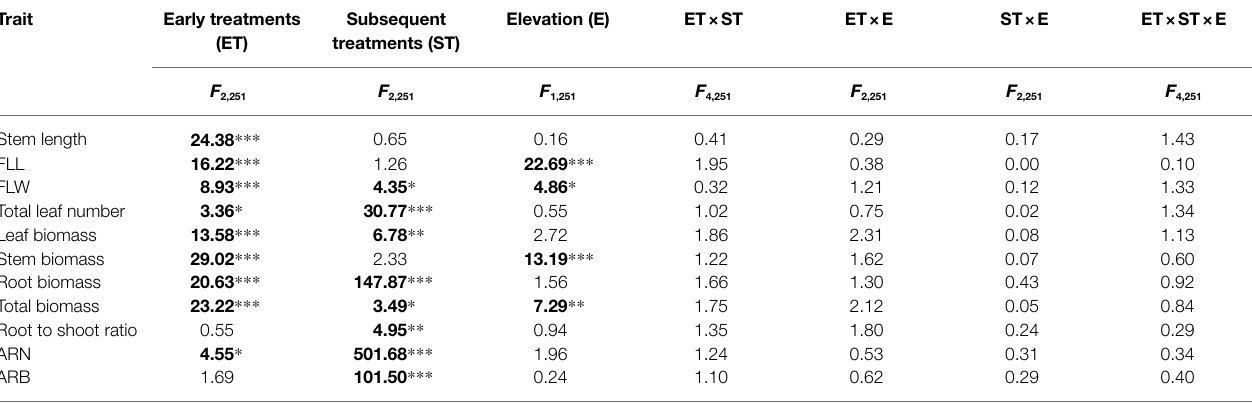
TABLE 2 | ANOVA results for effects of early treatments (ET: early control, early flooding, and early eutrophic flooding), subsequent treatments (ST: control, flooding, and eutrophic flooding), and elevation (E: low and high) on stem length, functional leaf length and width, total leaf number, leaf biomass, stem biomass, root biomass, total biomass, root to shoot ratio, adventitious root number, and adventitious root biomass in P. hydropiper at the end of subsequent treatments on day 20. Trait